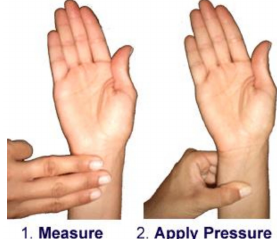
Figure 2. The point of pressure in the acupressure group.